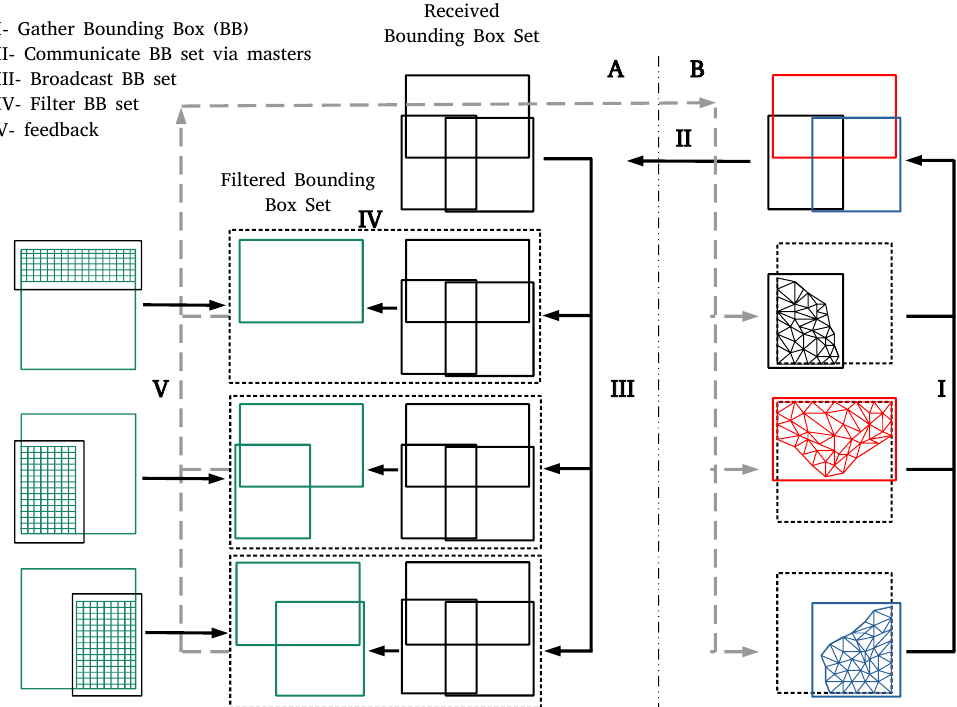
Figure 1. Two-level initialization scheme: the first level exchanges bounding boxes and establishes the communication channels between partner processes. The master processes of B gathers the bounding boxes from other processes (I) and sends them to the master process of solver A (II). The master process of solver A broadcasts the received bounding boxes to all other processes of solver A (III). Each process of A compares the received set of bounding boxes to its own bounding box to find the partner processes in solver B (IV). The complete set of sent bounding boxes is drawn in black, while the green boxes represent the subset relevant for the respective process of solver A. The filtered set of bounding boxes is communicated to the processes of solver B via master communication, such that not only the processes of solver A, but also the processes of solver B know their potential communication partners